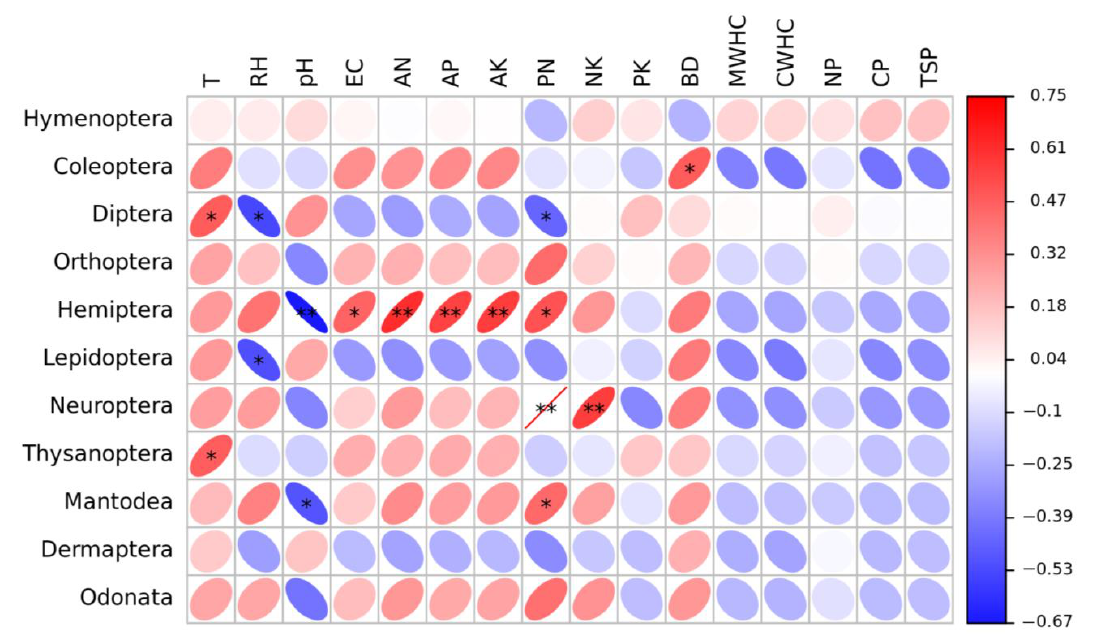
Figure 6. Pearson correlation coefficients between insect taxa order and soil factors in the Guandi Mountain. Left column is the taxa of insect order investigated in this study. Top row is the physical and chemical properties of the soil, where T means soil temperature, RH means soil relative humidity, pH means soil pH, EC means soil electric conductivity, AN means soil available nitrogen, AP means soil available phosphorus, AK means soil available potassium, PN means the ratio of available phosphorus to available nitrogen, NK means the ratio of available nitrogen to available potassium, PK means the ratio of available phosphorus to available potassium, BD means soil bulk density, MWHC means soil maximum water holding capacity, CWHC means soil capillary water holding capacity, NP means soil noncapillary porosity, CP means soil capillary porosity, TSP means total soil porosity. The values in the scale bar represent the correlation coefficients. The color of the circle indicates the direction of the correlation, where red indicates positive correlation and blue indicates negative correlation, and the darker the color indicates stronger correlation. The size of the circle indicates the strength of the correlation, and the larger the circle, the stronger the correlation. * p < 0.05, ** p < 0.01.